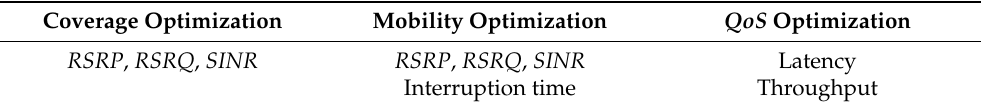
Table 2. Key performance indicators per RAN Optimization use case. Coverage Optimization Mobility